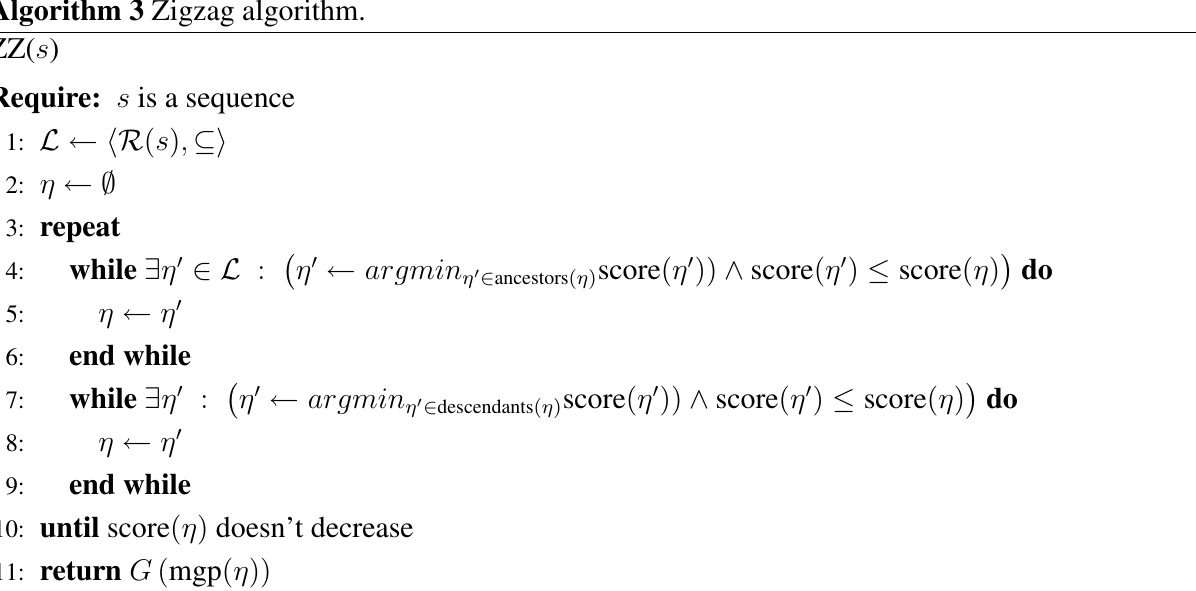
Algorithm 3 Zigzag